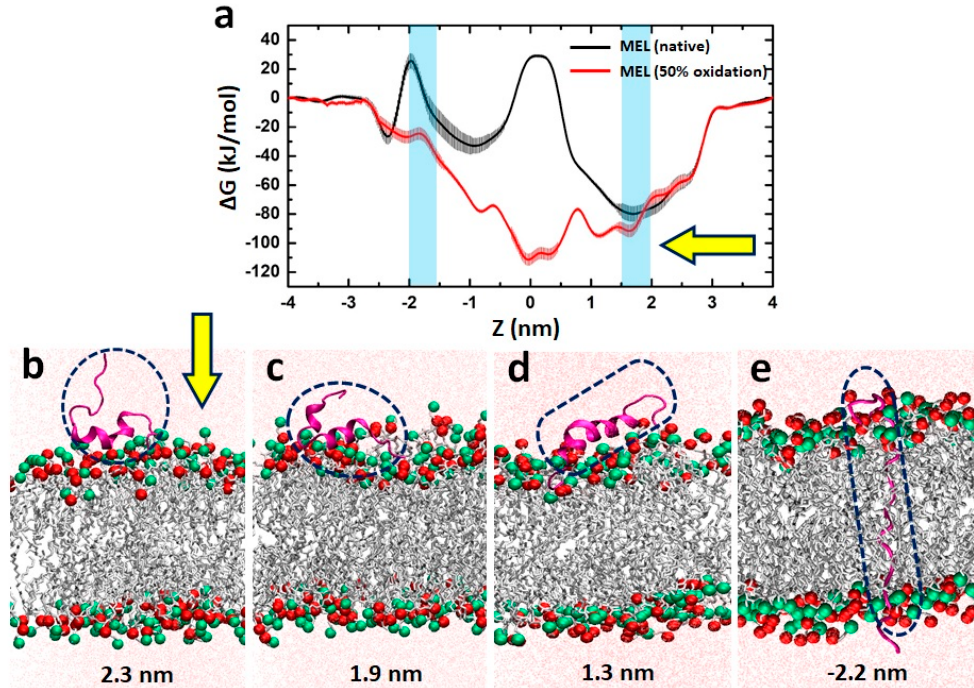
Figure 9. ( a ) Free energy profiles for translocation of MEL across the native and 50% oxidized PLB. ( b – e ) MEL at different positions of the native PLB. P and N atoms in the PLB are shown in red and green, respectively. MEL (shown within dashed circles/ovals) and the lipid tails are presented in magenta and grey, respectively. The light blue colour in ( a ) represents the upper (right) and lower (left) head groups of the PLB. The yellow arrows in ( a , b ) indicate the direction of MEL translocation. At the bottom of ( b – e ), the respective positions of the N-terminal of MEL are indicated, referring to the x-axis of ( a ).